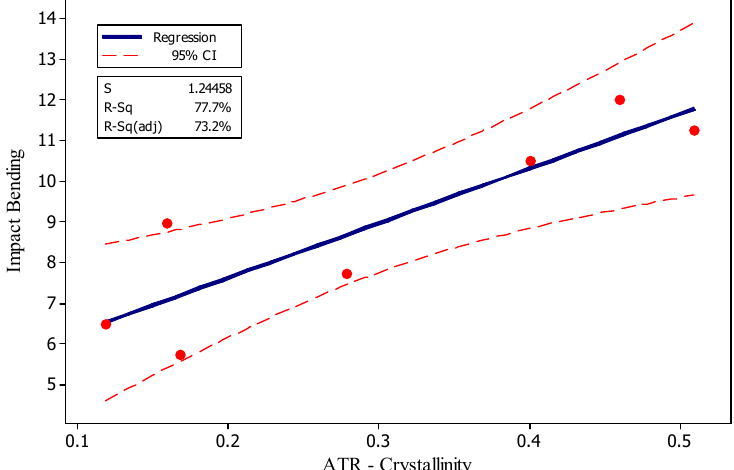
Figure 7. Fitted-line plot between Attenuated Total Reflectance-crystallinity versus impact bending in the seven treatments of Scots pine